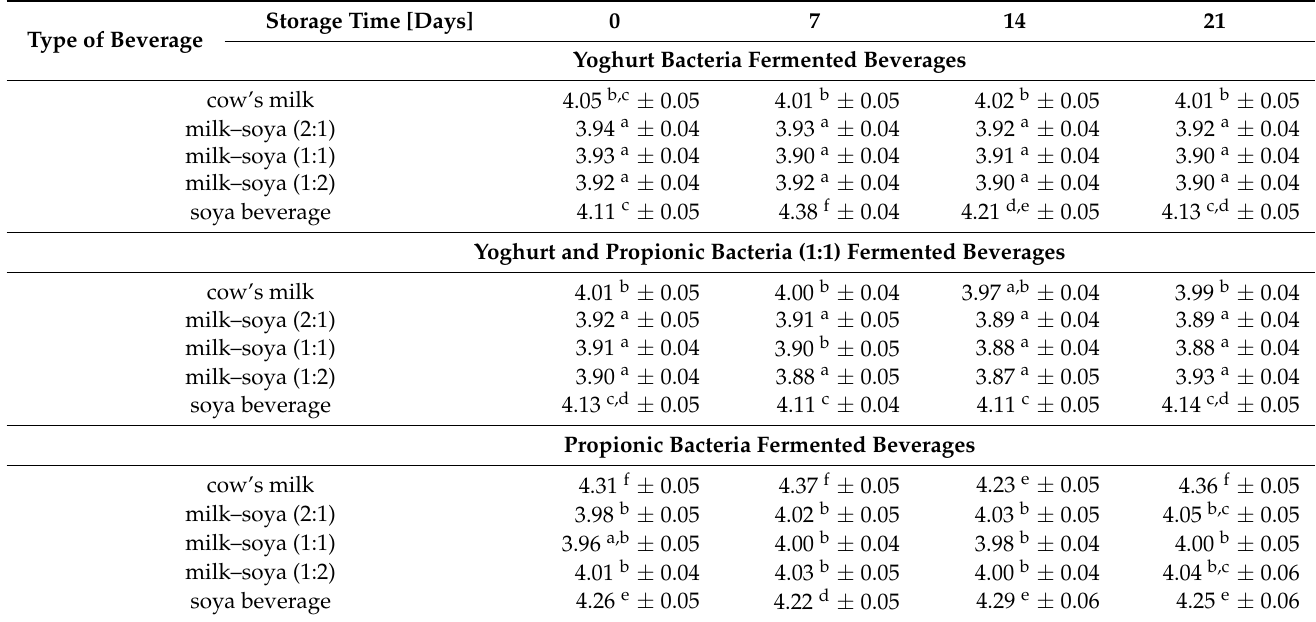
Table 2. pH values of milk, milk–soya, and soya yoghurt products obtained from beverages fermented using different starter cultures and stored at 5 ◦ C for 21 days (mean values and standard